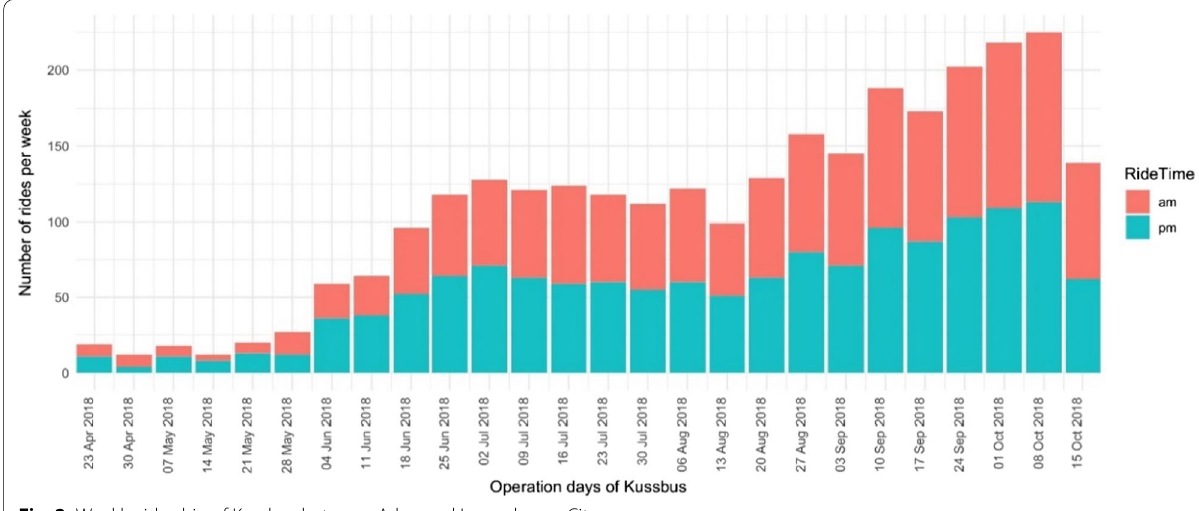
Fig. 2 Weekly ridership of Kussbus between Arlon and Luxembourg City